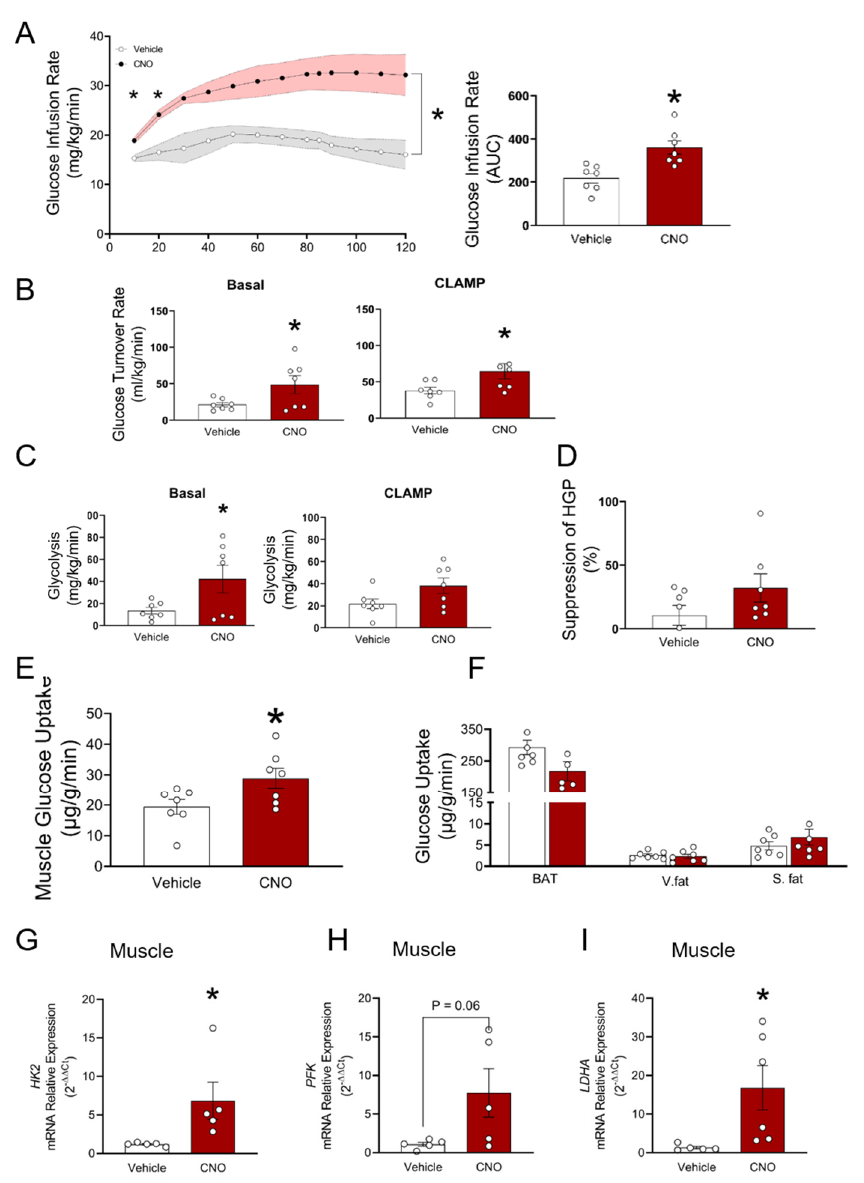
Figure 6. Hyperinsulinemic-euglycemic clamp during acute activation of ARC GHR neurons. ( A ) Glucose infusion rates (GIR) and AUC. ( B ) Glucose turnover rate under basal and steady-state conditions. ( C ) Whole body glycolysis under basal and steady-state conditions. ( D ) Percentage suppression of hepatic glucose production. ( E ) Glucose uptake rates in skeletal muscle (gastroc, gastrocnemius muscle), and ( F ) brown adipose tissue (BAT), and white adipose tissue. V. fat—visceral fat; S. fat—subcutaneous fat. ( G ) HkII, ( H ) Pfk, and ( I ) Ldha mRNA expression in muscle in vehicle and CNO injected mice at 18–20 weeks of age; n = 7 mice per group. Mean ± SEM, *, p < 0.05.